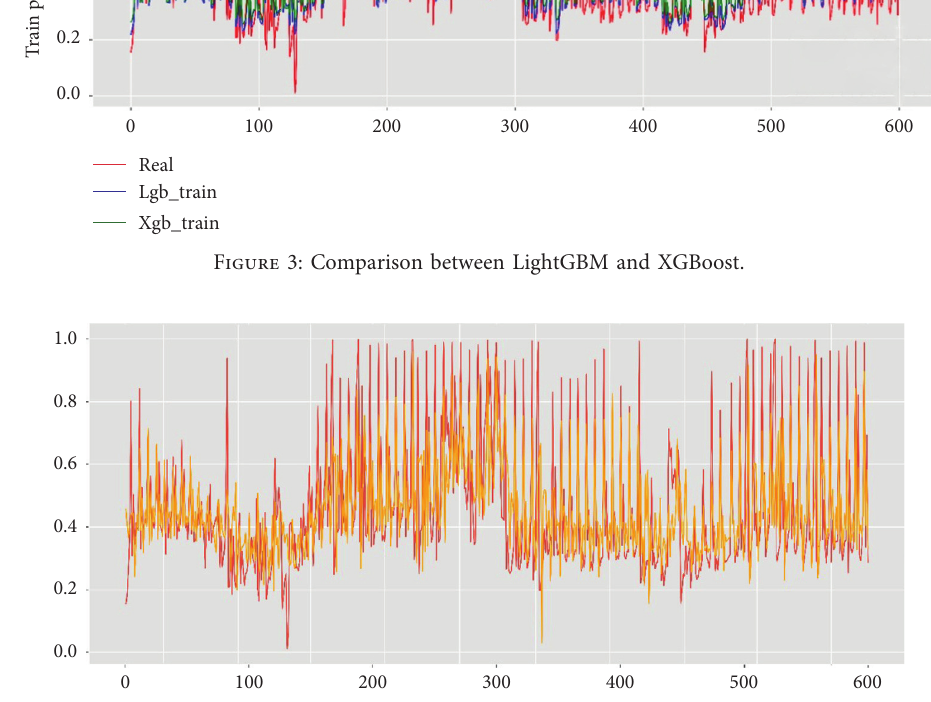
Figure 4: Comparison of ARIMA model predicted value and real value. Table 2: Performance comparison of LightGBM, XGBoost, and ARIMA